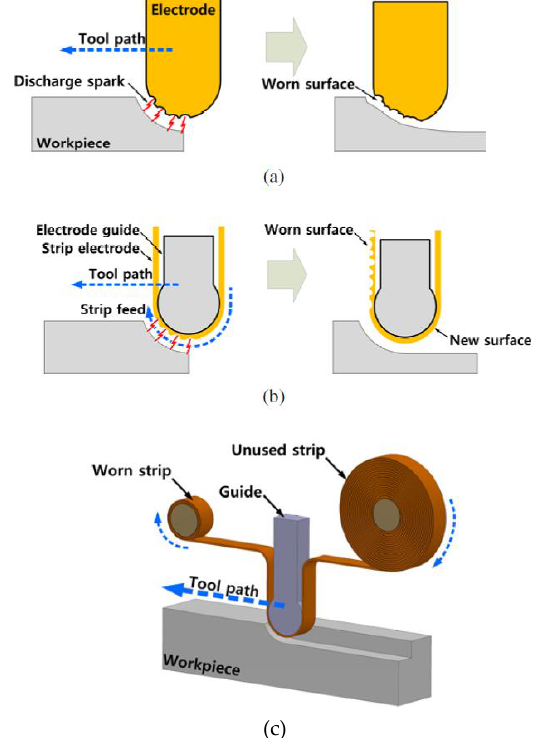
Figure 16. ( a ) General EDM; ( b ) strip EDM; and ( c ) concept of the strip EDM